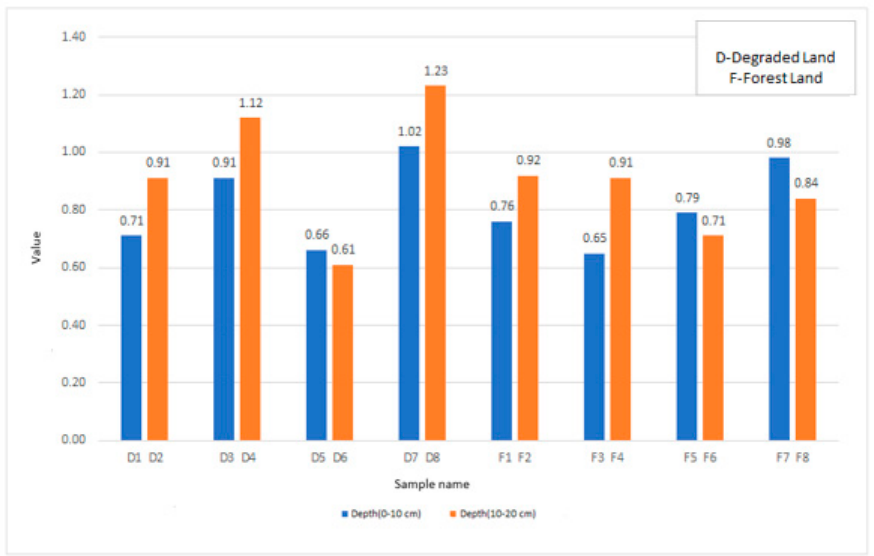
Figure 8. Variation of bulk density depending on the depth and type of land use.